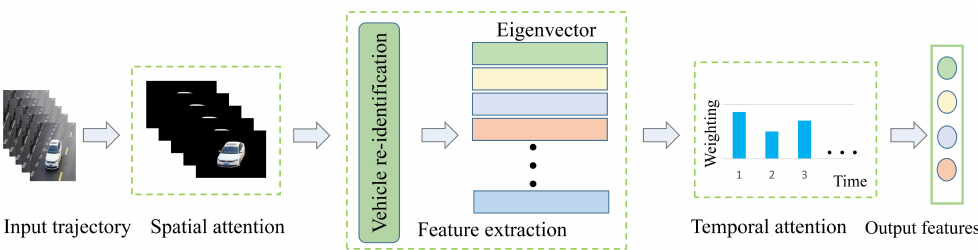
Figure 9. Vehicle Re-identification Based on Spatio-temporal